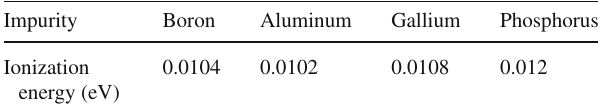
Table 2 Ionization energies of shallow impurities in Ge Impurity Boron Aluminum Gallium Phosphorus Ionization energy (eV)